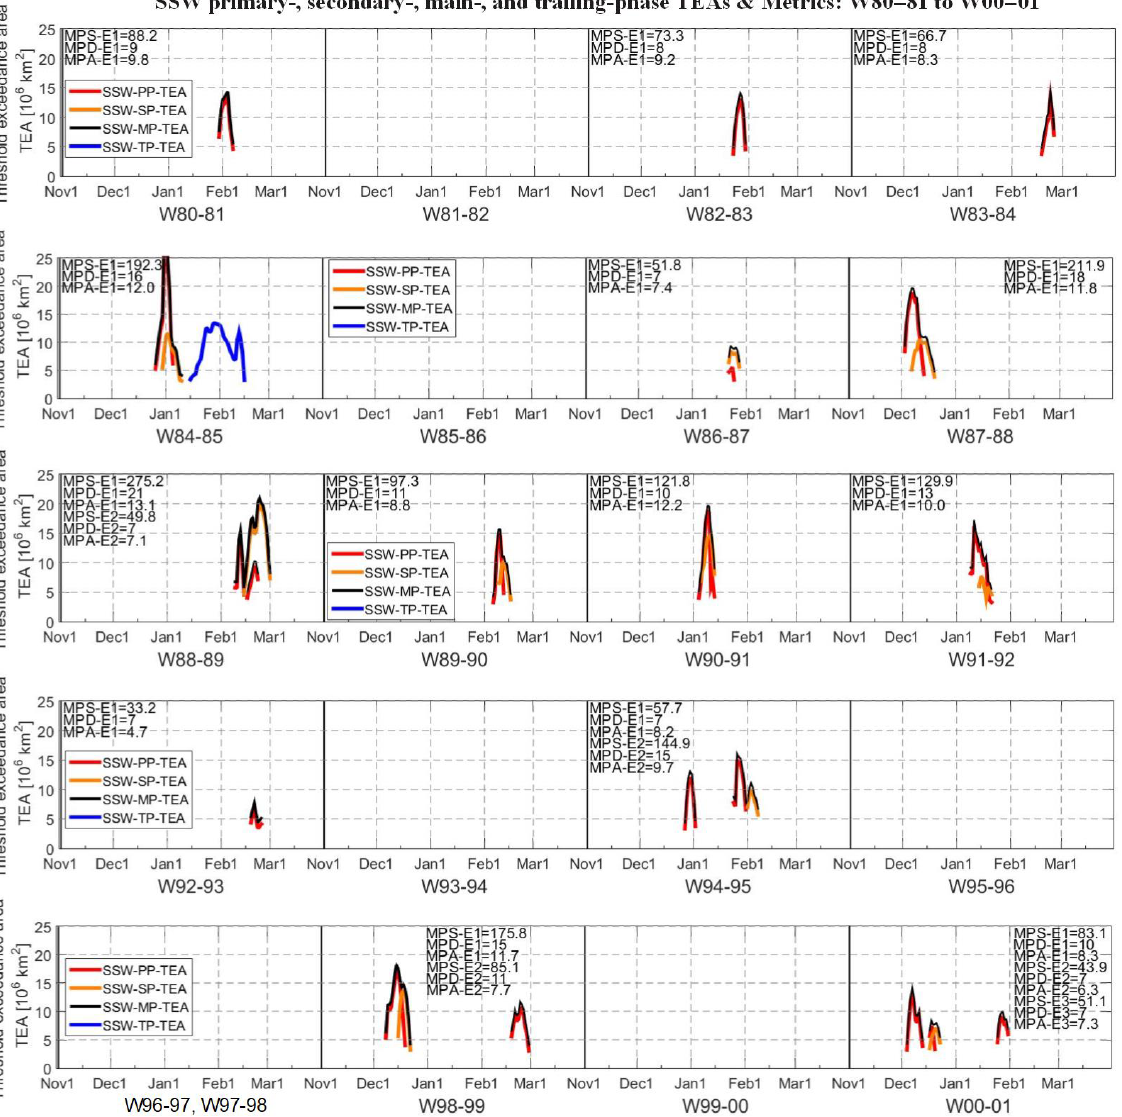
Figure 9. Time evolution of the SSW TEAs (SSW-PP-TEA, SSW-SP-TEA, SSW-MP-TEA, SSW-TP-TEA) and related SSW metrics (MPS, MPD, MPA) for all recorded SSW events of the winters W80–81 to W00–01; same plotting style as Fig.